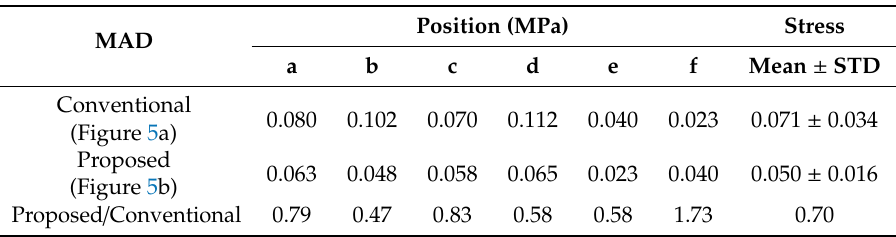
Figure 5. Comparative analyzed points of stress distribution: ( a ) conventional and ( b ) proposed MAD. Table 2. Comparison of stresses between the conventional and proposed MAD.